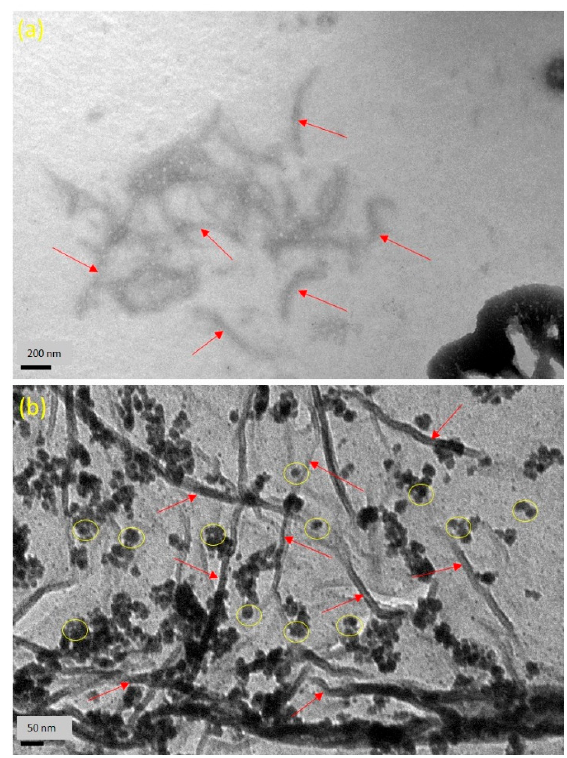
Figure 4. Transmission Electron Microscopy (TEM) images of ( a ) CNC/Alg and ( b ) CNC/Ag/Alg composite films.